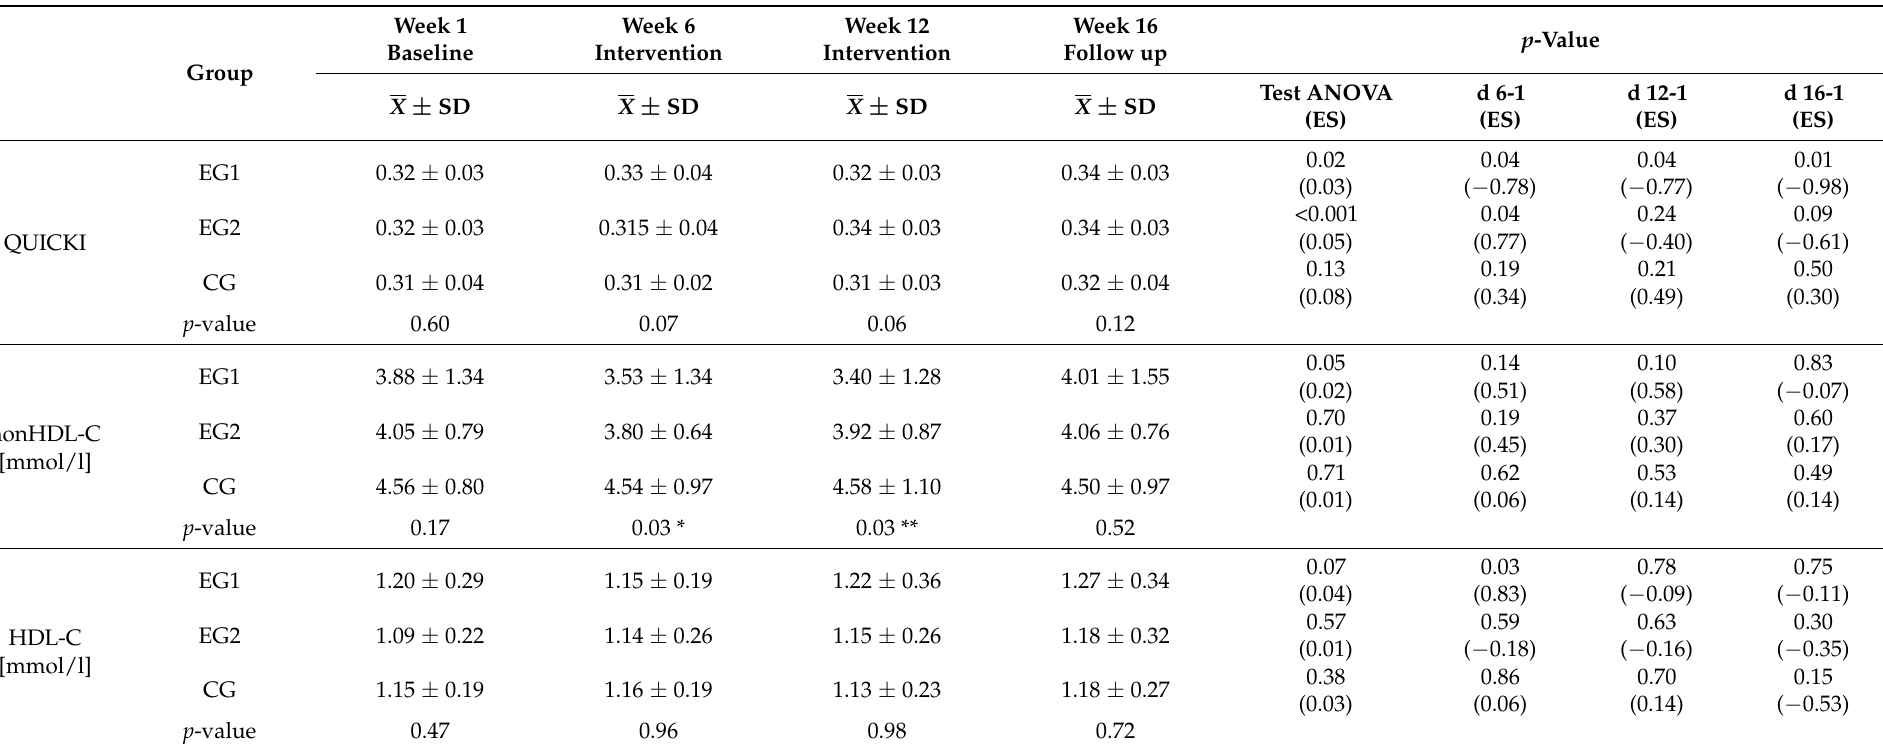
Table 3. Concentrations of quantitative insulin sensitivity check index (QUICKI), nonHDL-C and HDL-C cholesterol in the participants’ blood in the aerobic group (EG1), aerobic-resistance group (EG2), and control group